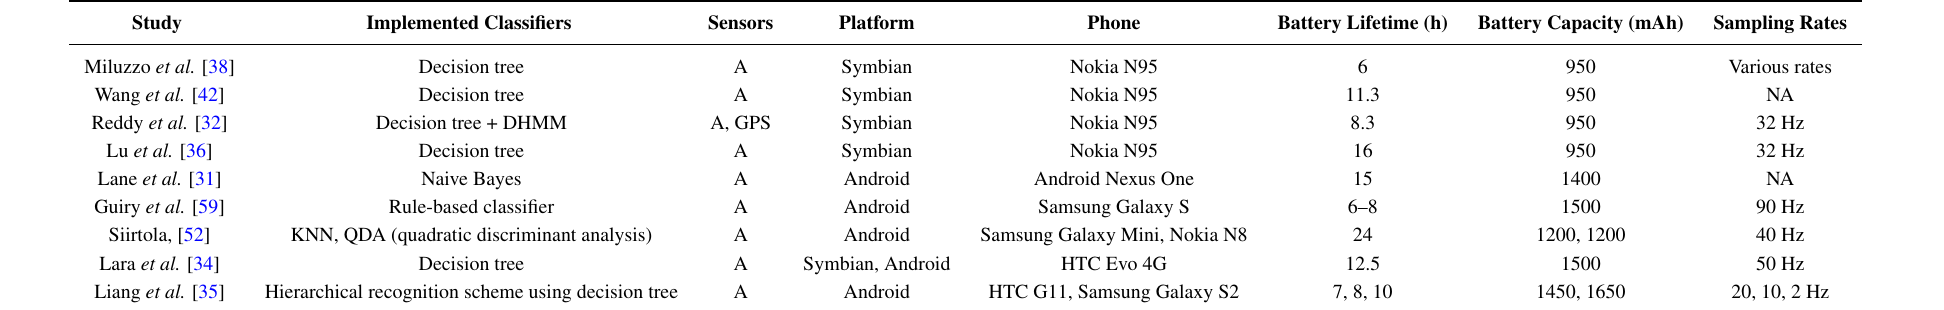
Table 7. Details of battery usage analysis.